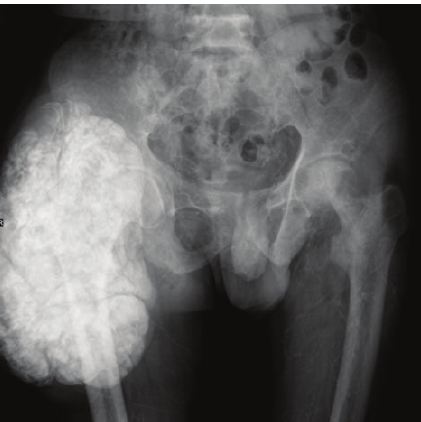
Figure 1: Pelvic X-ray indicated a high density mass, measuring about 26 × 18 cm in size near the right hip joint.